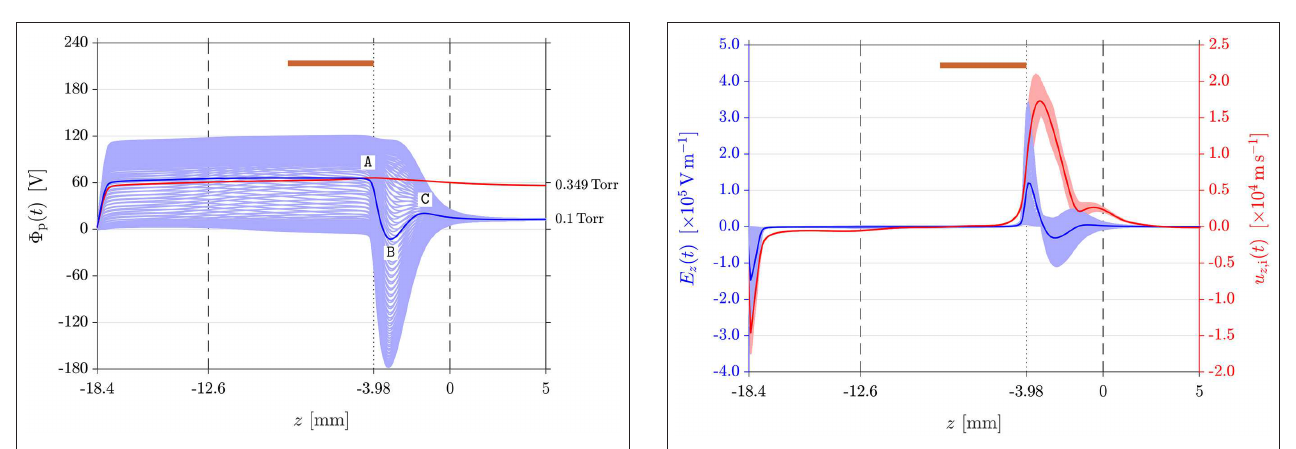
FIGURE 4 | Temporally varying electric field E z ( t ) (light blue lines) and ion drift velocity u z ,i ( t ) (light red lines) along the z -axis for the 0.1Torr outlet pressure DL simulation. The blue and red solid lines show the cycle average E z and u z ,i respectively. Vertical dashed and dotted lines are defined in Figure 2